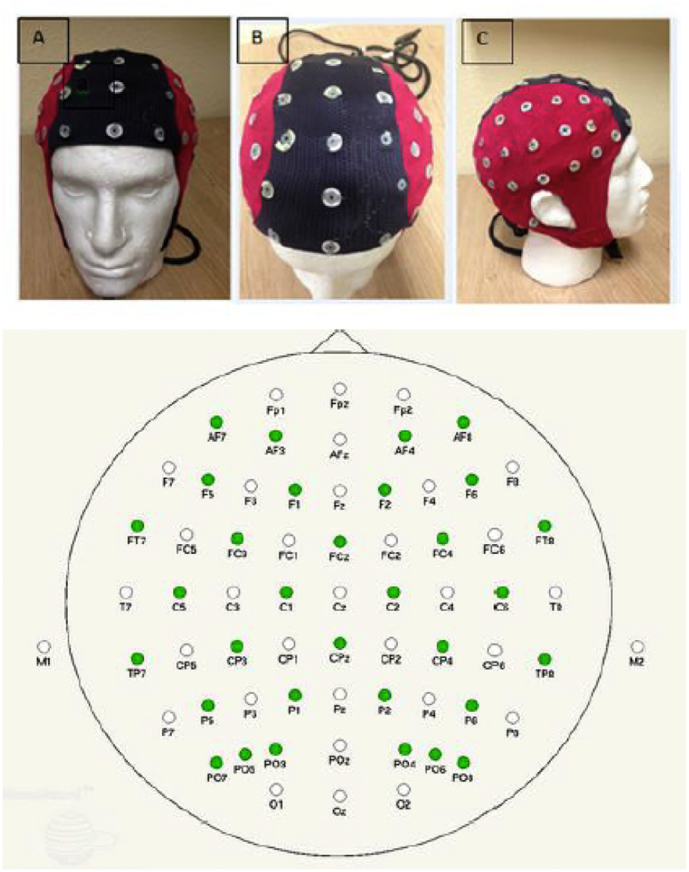
The EEG cap layout, the top figures shows frontal, top and lateral view of the cap, the bottom figure shows the 10–20 layout with an additional 10–10 electrodes, the layout provided by the ANT-Neuro, Enscheda, the Netherlands.